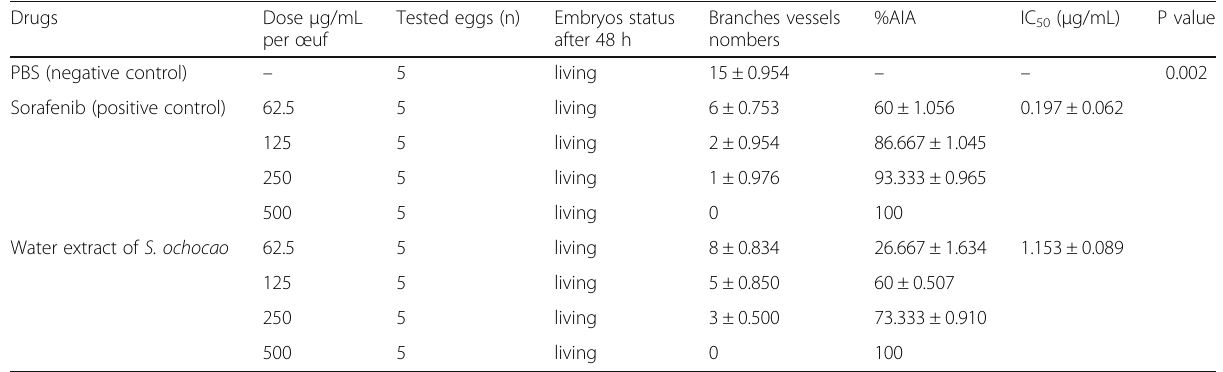
Table 3 Antiangiogenic effect of S. ochocao and Sorafenib